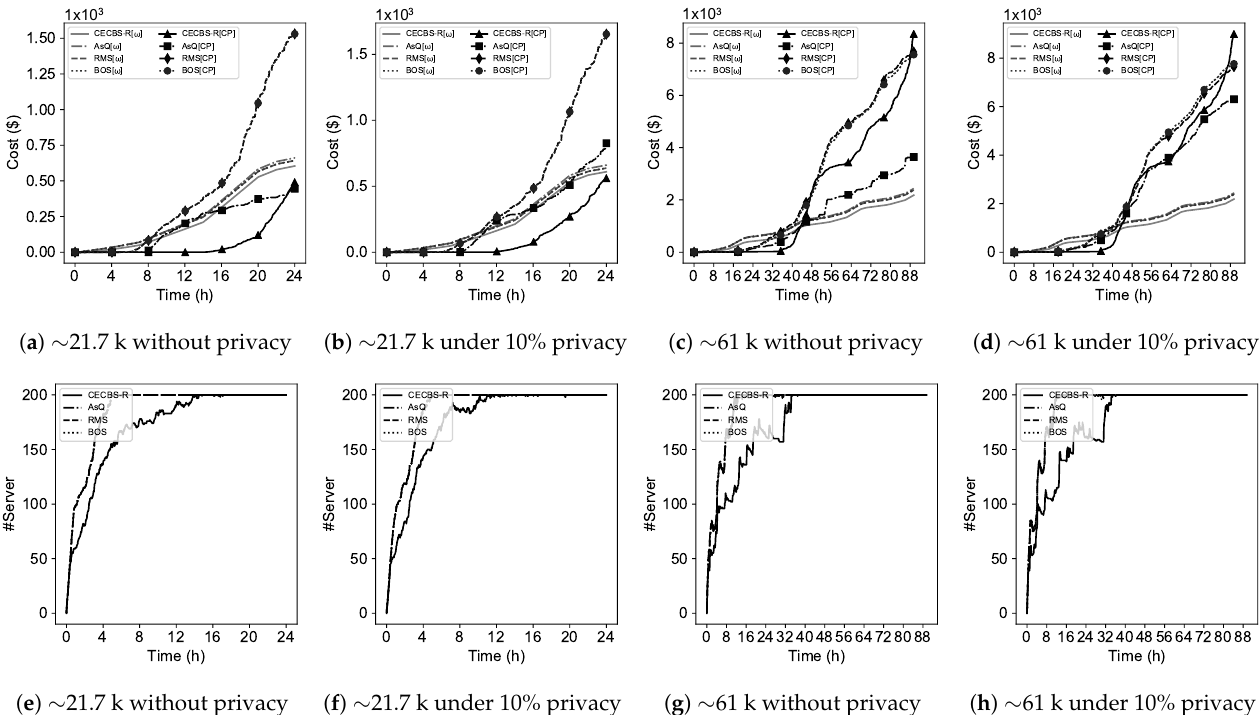
Figure 11. The accumulated edge ( ω ) and public cloud ( CP ) cost followed by the edge server usage for ∼ 21.7 k and ∼ 61 k